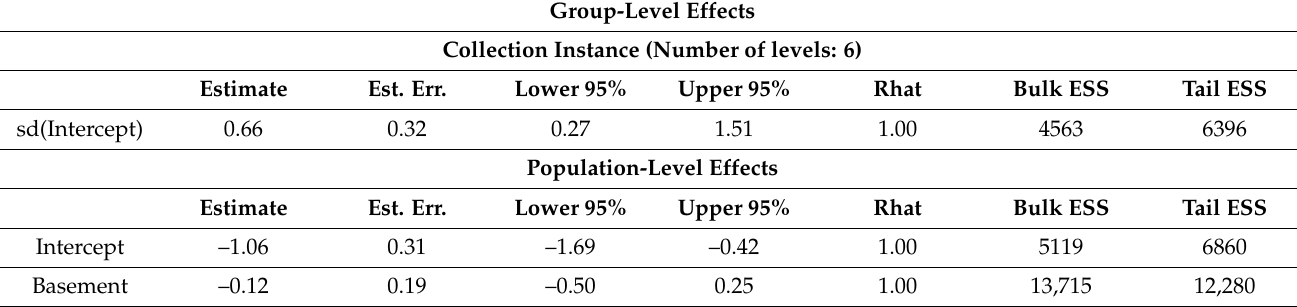
Table A1. Summary of Bayesian generalised linear model to assess the significance of basement versus non-basement ovitrap locations on mosquito egg presence (Bernoulli response variable, log-link function). There were six collection events which were treated as group-level effects that contributed an intercept. Population-level effects were an intercept and the effect of the basement variable (i.e., whether the trap was placed in a basement). Columns for effects and estimated parameters are: posterior mean estimate (“Estimate”); standard error of the posterior mean (“Est. Err.”); lower limit of the 95% Bayesian credible interval (“Lower 95%”); upper limit of the 95% Bayesian credible interval (“Upper 95%”); Gelman-Rubin convergence statistic (“Rhat”); bulk effective sample size for